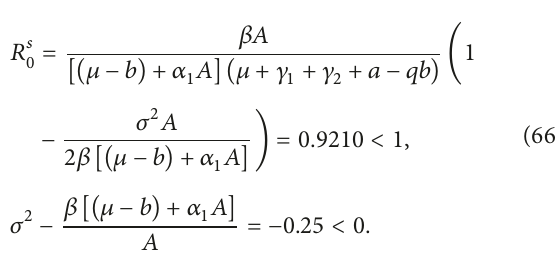
In this case, we